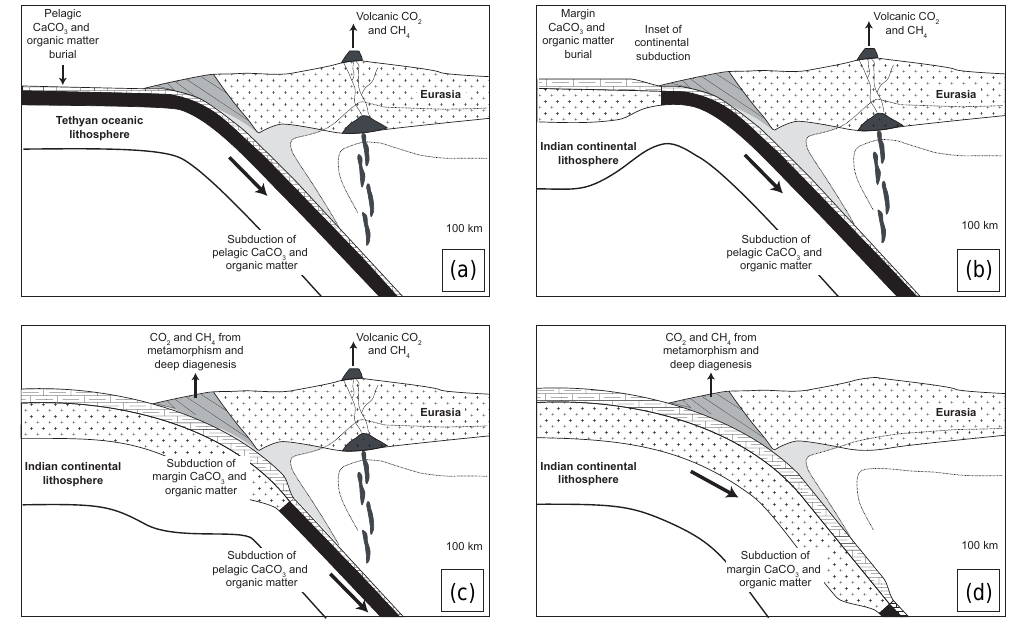
Figure 3. Sketches illustrating the carbon input and outputs considered in the model during subduction. (a) General sketch for subduction of oceanic crust and pelagic sediments (Africa, Arabia and India before Indian continental subduction). Carbon deposited as carbonate and organic carbon in pelagic sediments, as well as crustal carbonate, is partly recycled at sub-arc depth and incorporated in arc magmas. (b) Similar sketch at the inset of Indian continental subduction. (c) Subduction of northern Indian margin before it reaches sub-arc depth. Carbon originating from low-grade metamorphism of Indian margin sediments is partly released to the atmosphere, making additional greenhouse gas to that released at arc volcanoes. (d) Arc volcanism stops as Indian continental crust reaches sub-arc